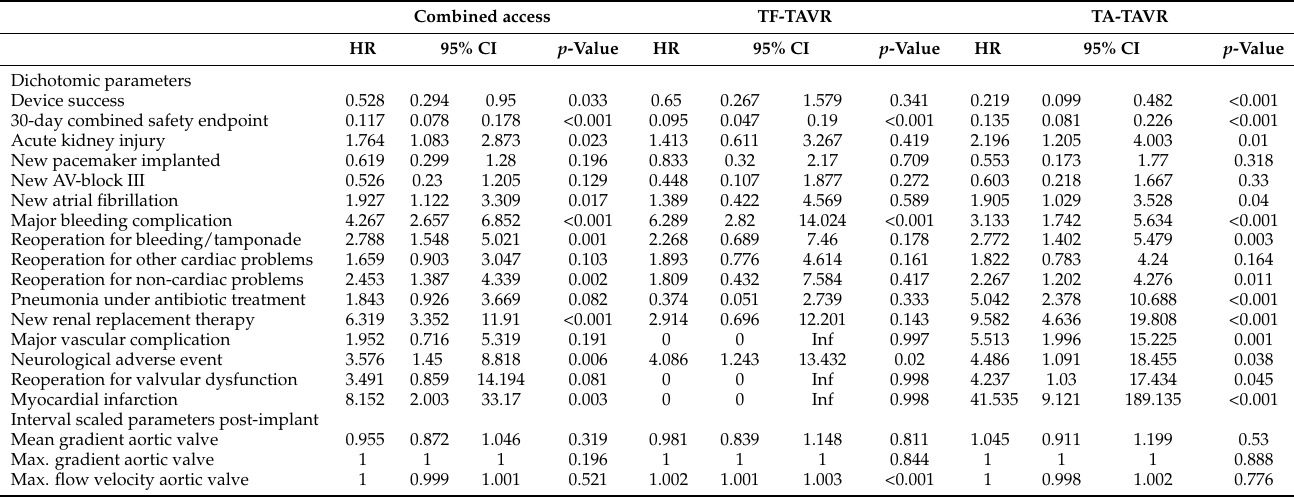
Table 4. Univariate Cox regression analyses of futile events based on postinterventional adverse events. A hazard ratio (HR) above 1 increases the risk, below 1 decreases the risk of